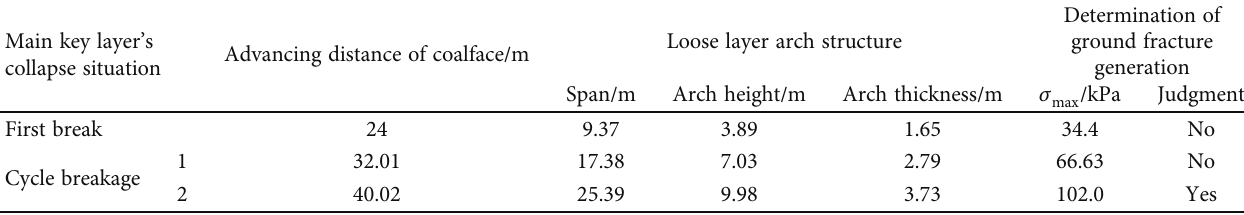
Figure 17: Arch beam structure and ground fi ssures. Table 2: Determination of ground fi ssure generation.